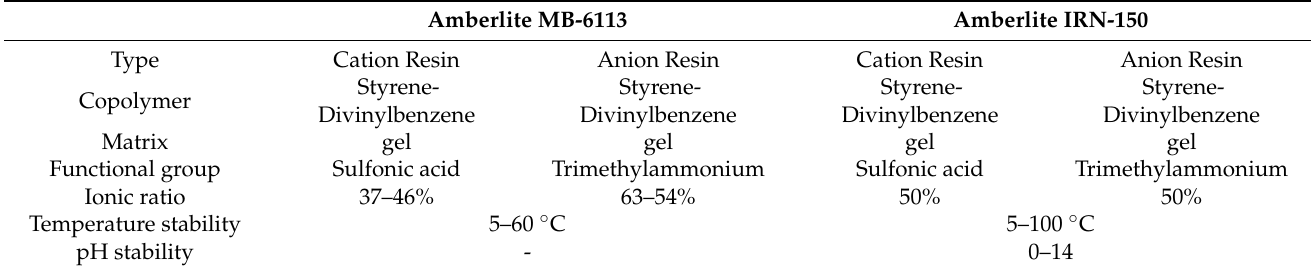
Table 1. Chemical–physical properties of Amberlite MB-6113 and Amberlite